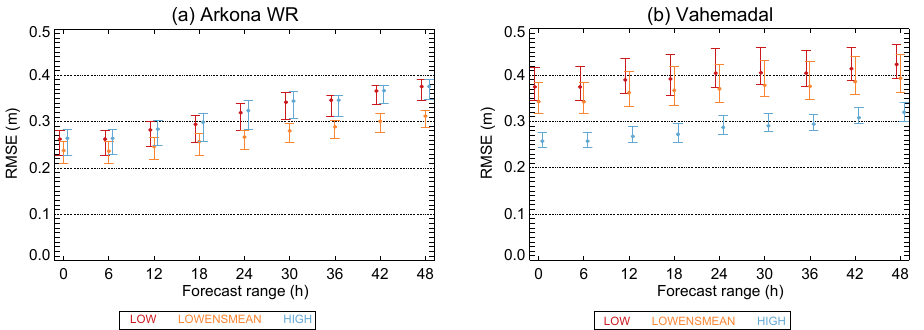
Figure 7. RMSE for selected forecast ranges for the Arkona WR (a) and Vahemadal site (b) for the LOW, LOWENSMEAN and HIGH forecasts. Error bars show the 5% and 95% confidence bands calculated by bootstrapping.